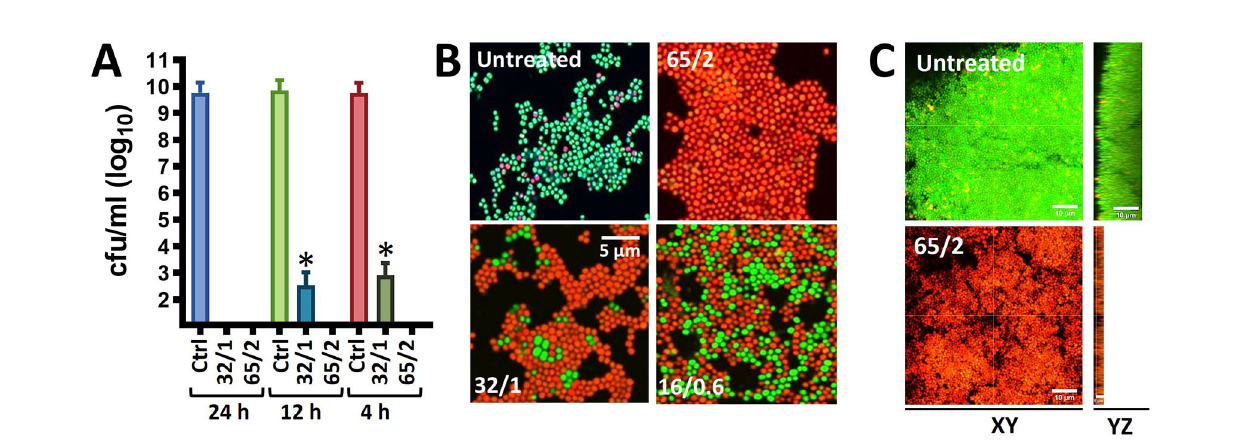
FIGURE 2 | MoWa kills preformed bio fi lm cultures of MRSA strain NRS384. (A) Bacteria were inoculated (1 × 10 6 cfu/ml) in (A) 24-well plates, or (B) 8-well slides, containing BHI broth and incubated for 4 h. Planktonic staphylococci were then removed and bio fi lms were washed and added with BHI broth. These bio fi lms were left untreated or treated for (A) 24 h, 12 h, or 4 h, or (B) for 4 h with a mixture levulinic acid (LA) and SDS at a concentration of 65/2 mM, 32/1 mM, or 16/0.6 mM. Bio fi lms were (A) harvested to obtain colony counts (cfu/ml) or (B) stained with the LIVE/DEAD BacLight bacterial viability kit and photograph using a Nikon upright fl uorescence microscope. Error bars in (A) represent the standard errors of the means calculated using data from at least three independent experiments. *p<0.05 compared to control. (C) Bacteria were inoculated as above in eight-well slides and incubated for 24 h after which bio fi lms were treated for 24 h with MoWa 65/2 mM or left untreated. Preparations were stained with the LIVE/DEAD BacLight bacterial viability kit and imaged using a confocal microscope. Panels show XY or YZ optical